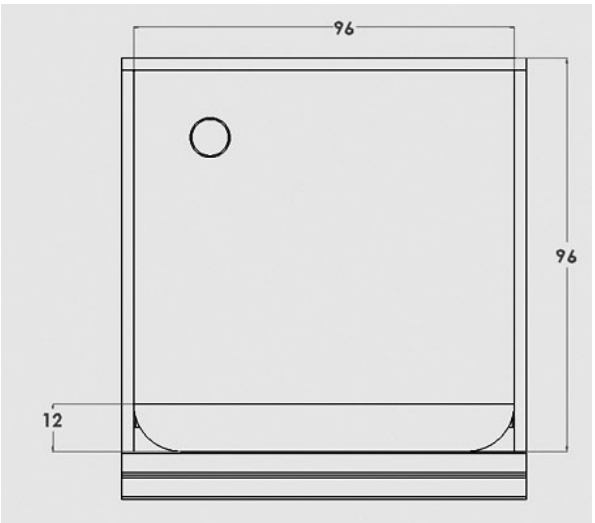
Figure 9. A typical cross section of holding tank designs. The dimensional unit is inch.